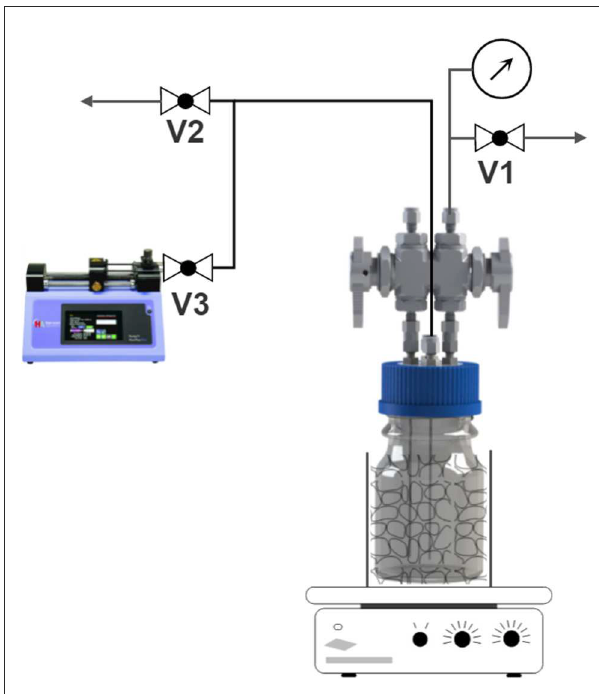
FIGURE1 Sketch of the experimental setup, which includes a bottle batch reactor, heating system, pressure sensor, and a syringe pump.